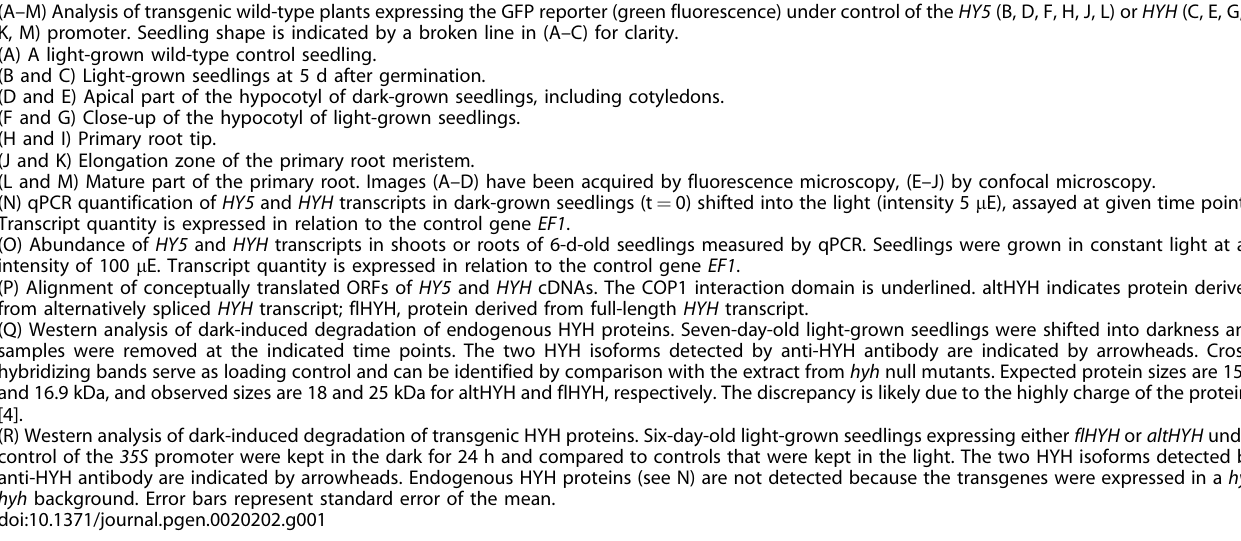
(R) Western analysis of dark-induced degradation of transgenic HYH proteins. Six-day-old light-grown seedlings expressing either flHYH or altHYH under control of the 35S promoter were kept in the dark for 24 h and compared to controls that were kept in the light. The two HYH isoforms detected by anti-HYH antibody are indicated by arrowheads. Endogenous HYH proteins (see N) are not detected because the transgenes were expressed in a hy5 hyh background. Error bars represent standard error of the